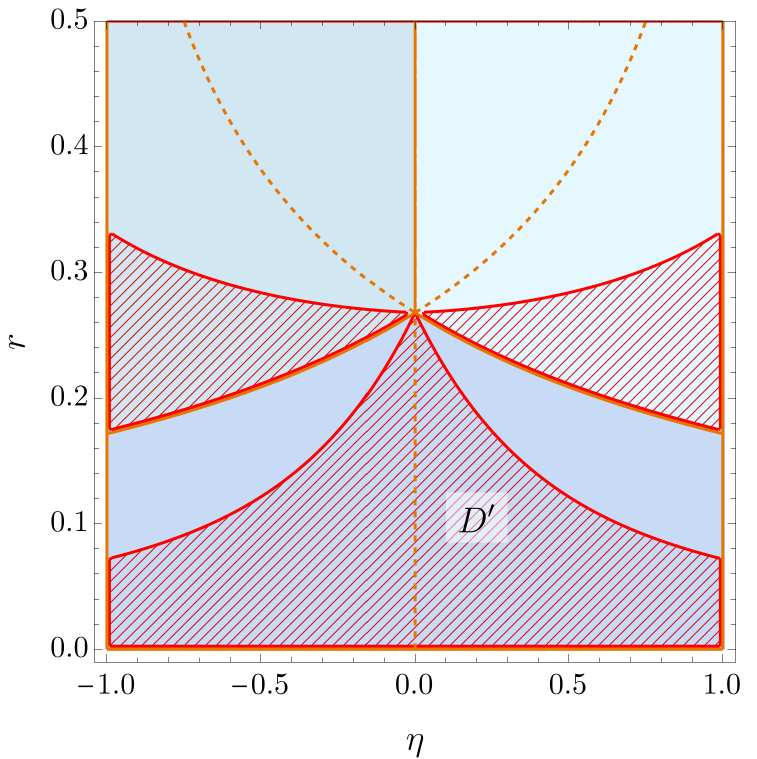
Figure 5 . The integration region D 0 , shown in orange, defined by extending D 1 into D 2 ∪ D 3 (indicated with the same colors as on the right of figure 4) such that the maximal value of r occurs at η = ± 1 , and then subtracting off the image of the extension as mapped back into D 1 under crossing symmetry. This ensures that the integrated constraints will not exhibit spin